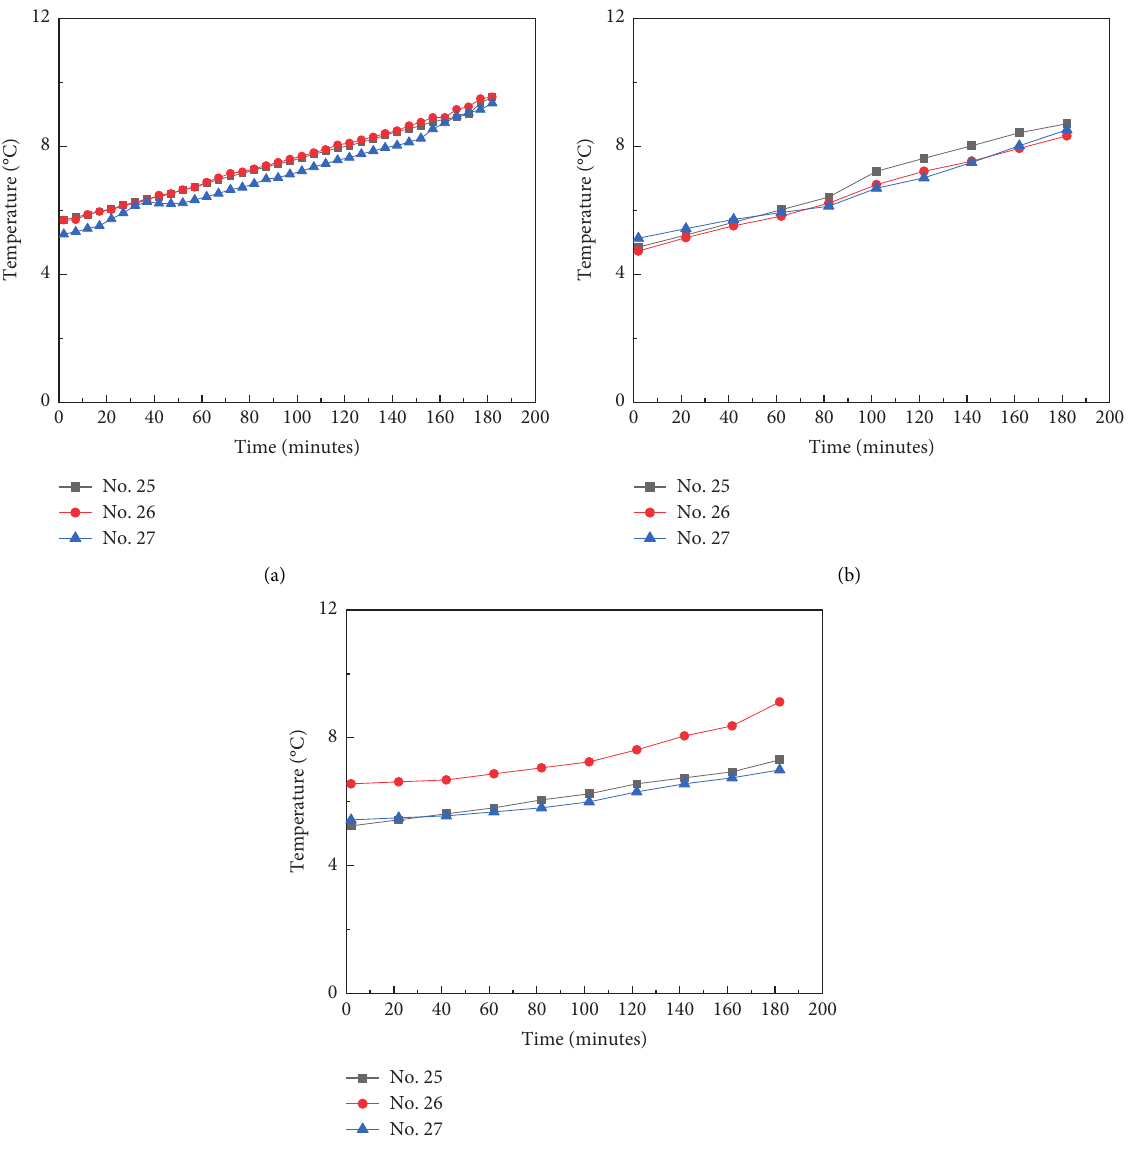
Figure 11: Temperature change curves of measuring points Nos. 25, 26, and 27 under various working conditions of temperature rise experiment: (a) − 2 ° C; (b) − 4 ° C; (c) − 8 ° C. Table 6: Temperature change rate of the second layer’s measuring points Nos. 25, 26, and 27 of the temperature rise experiment. Environmental conditions Average temperature when cooling Average temperature when heating Temperature change rate ( ° C/h) ( ° C) for 3 h ( ° C) for 3h ( ° C) − 2 5.5